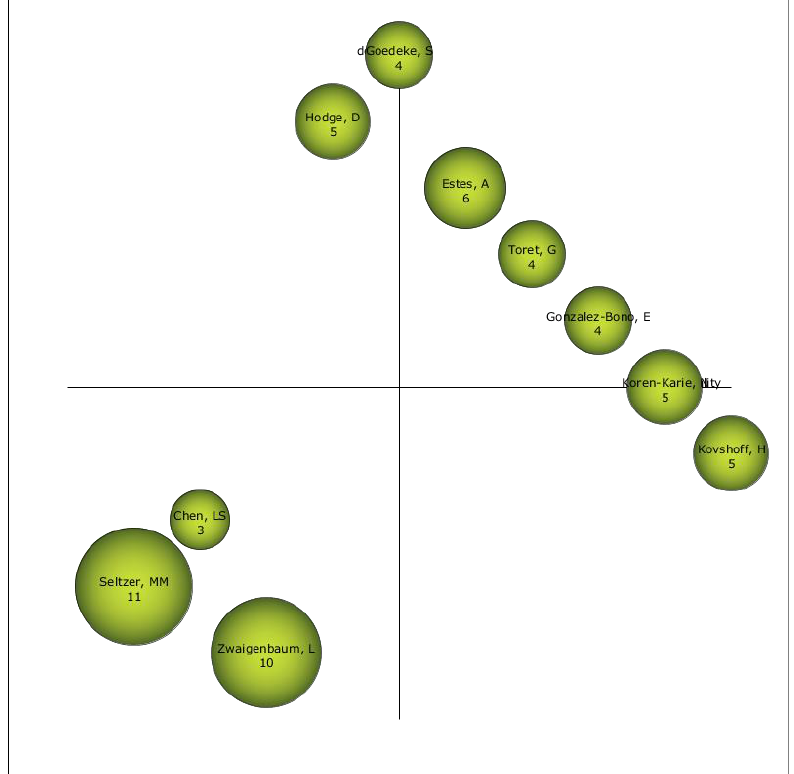
Figure 6. Strategic author diagram of the entire production.